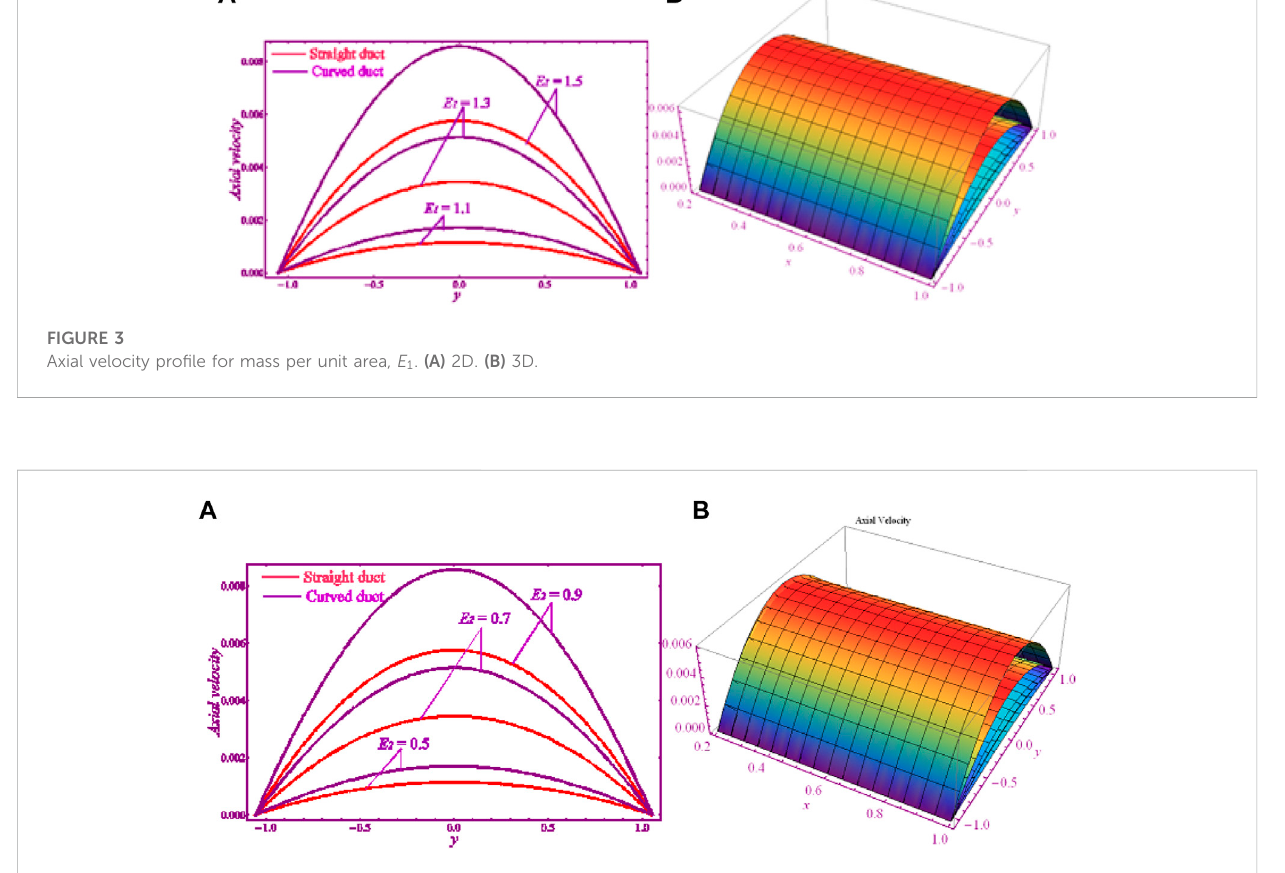
E , and amplitude ratio ϕ , both in 2-D and 3-D views, accordingly. 3 In each of these graphs, a quantitative comparison is also shown for curved ducts vs straight ducts. All these graphs have been structured for the horizontal range of coordinate y as [− a, a ] where